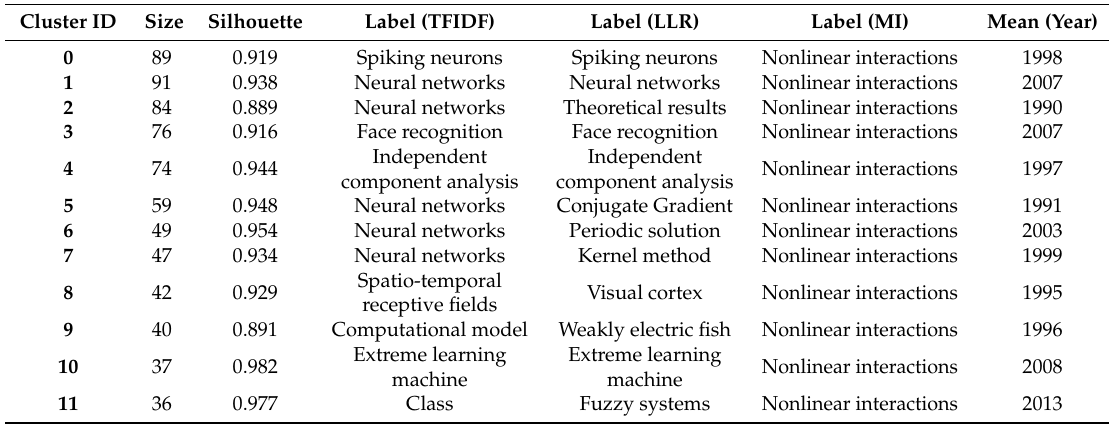
Table 7. Top 12 clusters in NC publications.